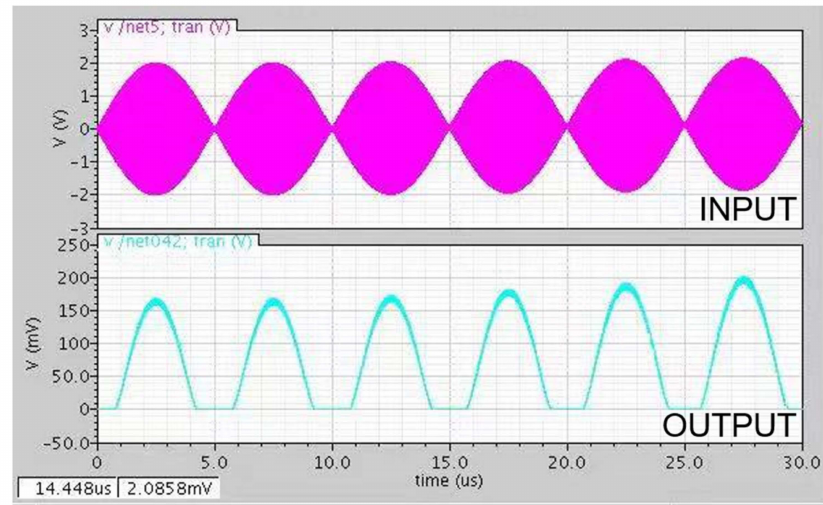
Figure 6. Charge pump simulation results.